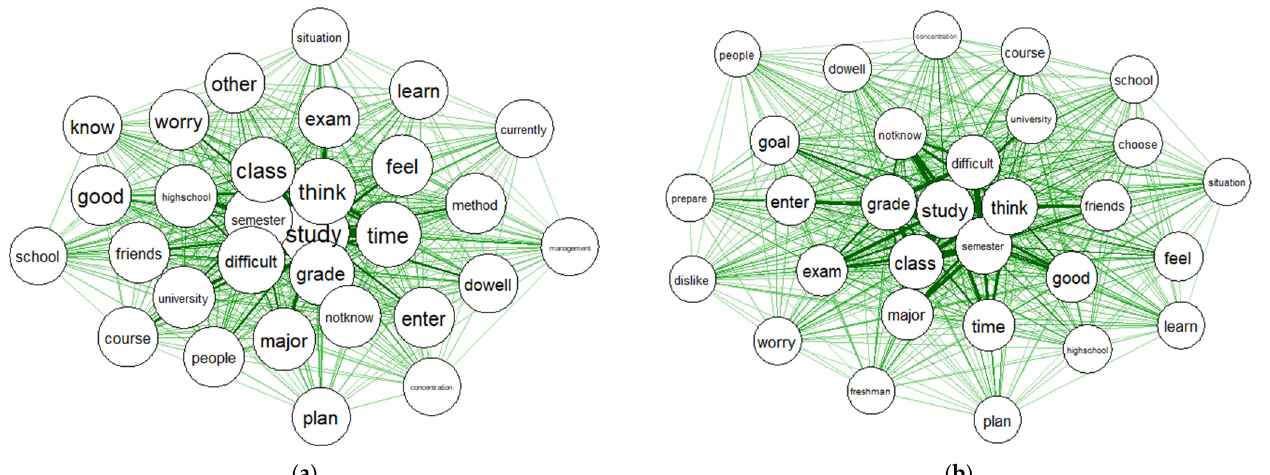
Figure 4. ( a ) Centrality of the top 30 keywords before COVID-19; ( b ) Centrality of the top 30 keywords after COVID-19.